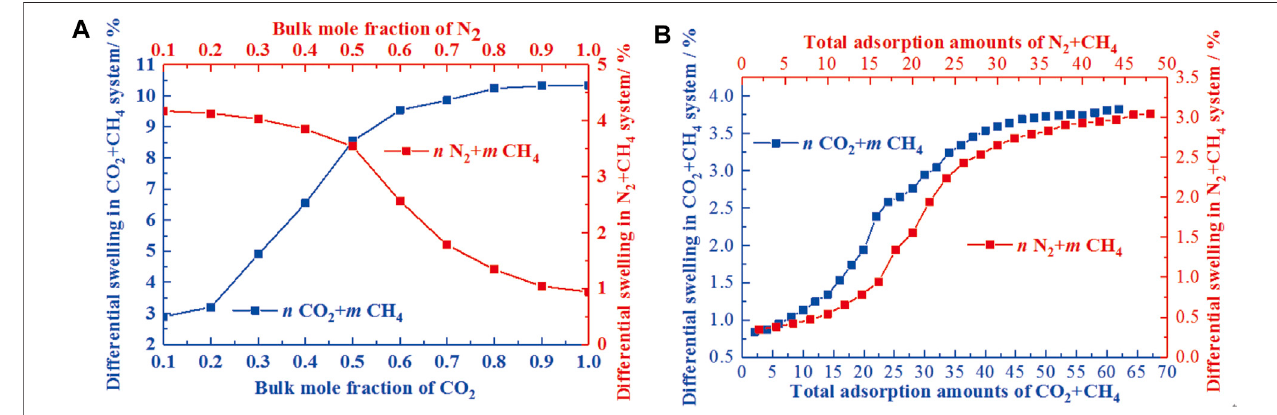
FIGURE9| Thevariationsofthedifferentialswellingofthe n CO 2 + m CH 4 andthe n N 2 + m CH 4 systemsunderthein fl uenceofmolefractionandadsorptionamount (Chen et al., 2021).